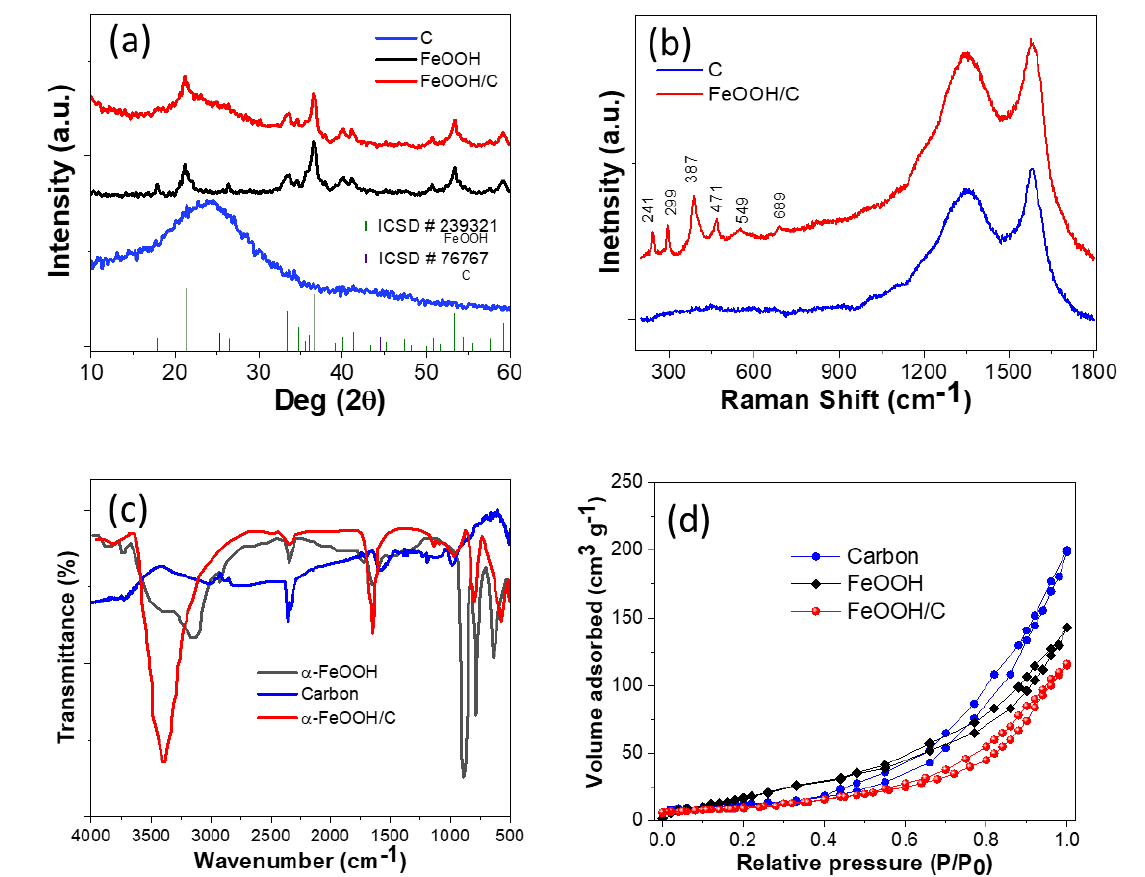
Figure 1. ( a ) Powder XRD of carbon, α − FeOOH and the FeOOH/C composite, ( b ) Raman spectra of carbon and the FeOOH/C composite, ( c ) FTIR spectra and ( d ) BET adsorption isotherm of carbon, α -FeOOH and the FeOOH/C composite.